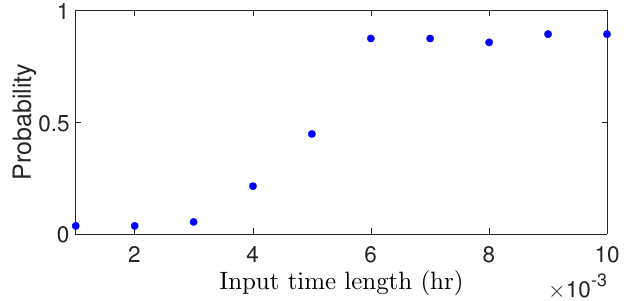
Figure 21. Probability of closed-loop stability vs. input time